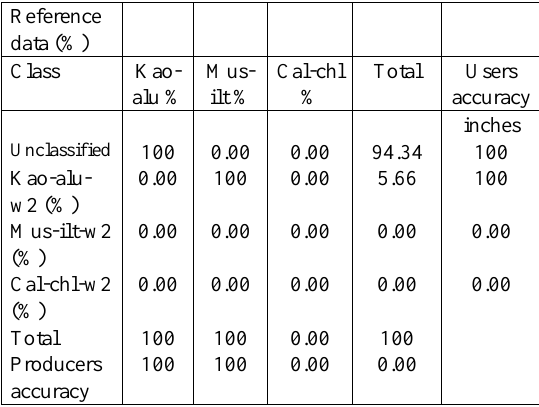
Table 5. Error matrix for SAM at 0.10 angle (library spectra) Overall Accuracy = 100%; Kappa Coefficient =